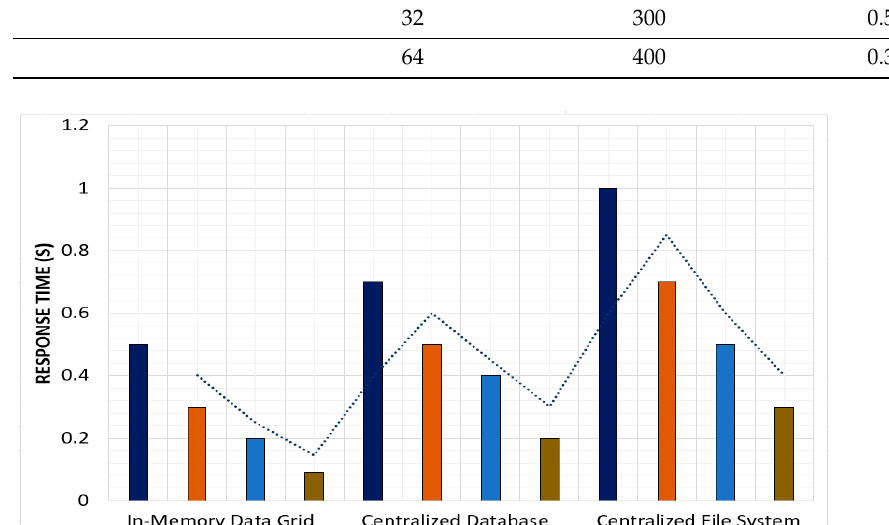
Figure 7. The response time based on the number of nodes and tasks.